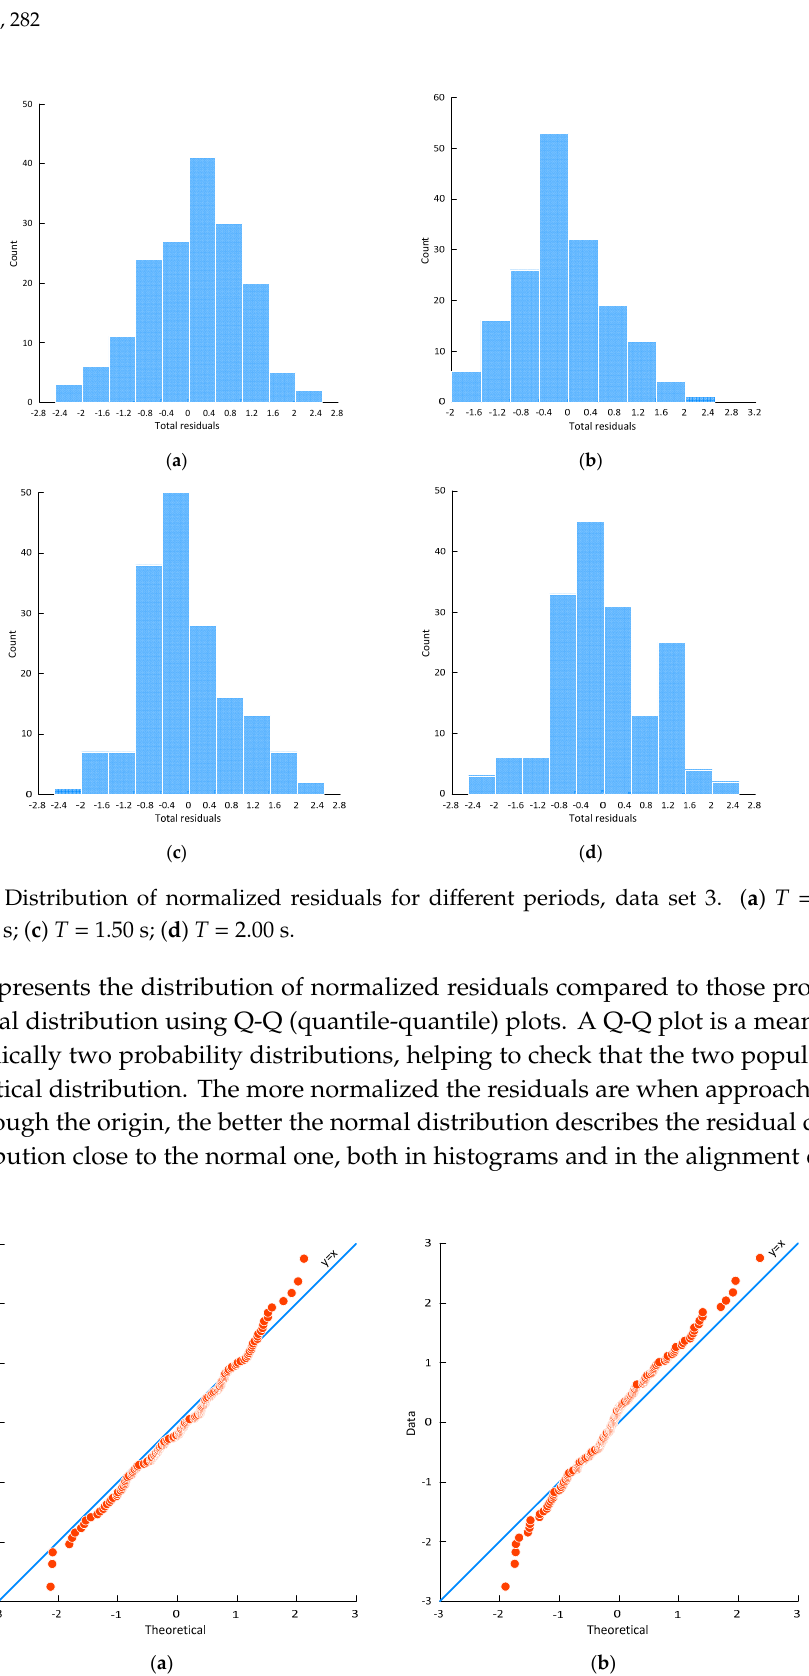
( b ) Figure 17. Q-Q plot, dataset 3. ( a ) T = 1.50 s; ( b ) T = 2.00 s. Two quantities can be introduced: the inter-event and the intra-event residuals. Inter-event residuals are calculated [41] using the following equation